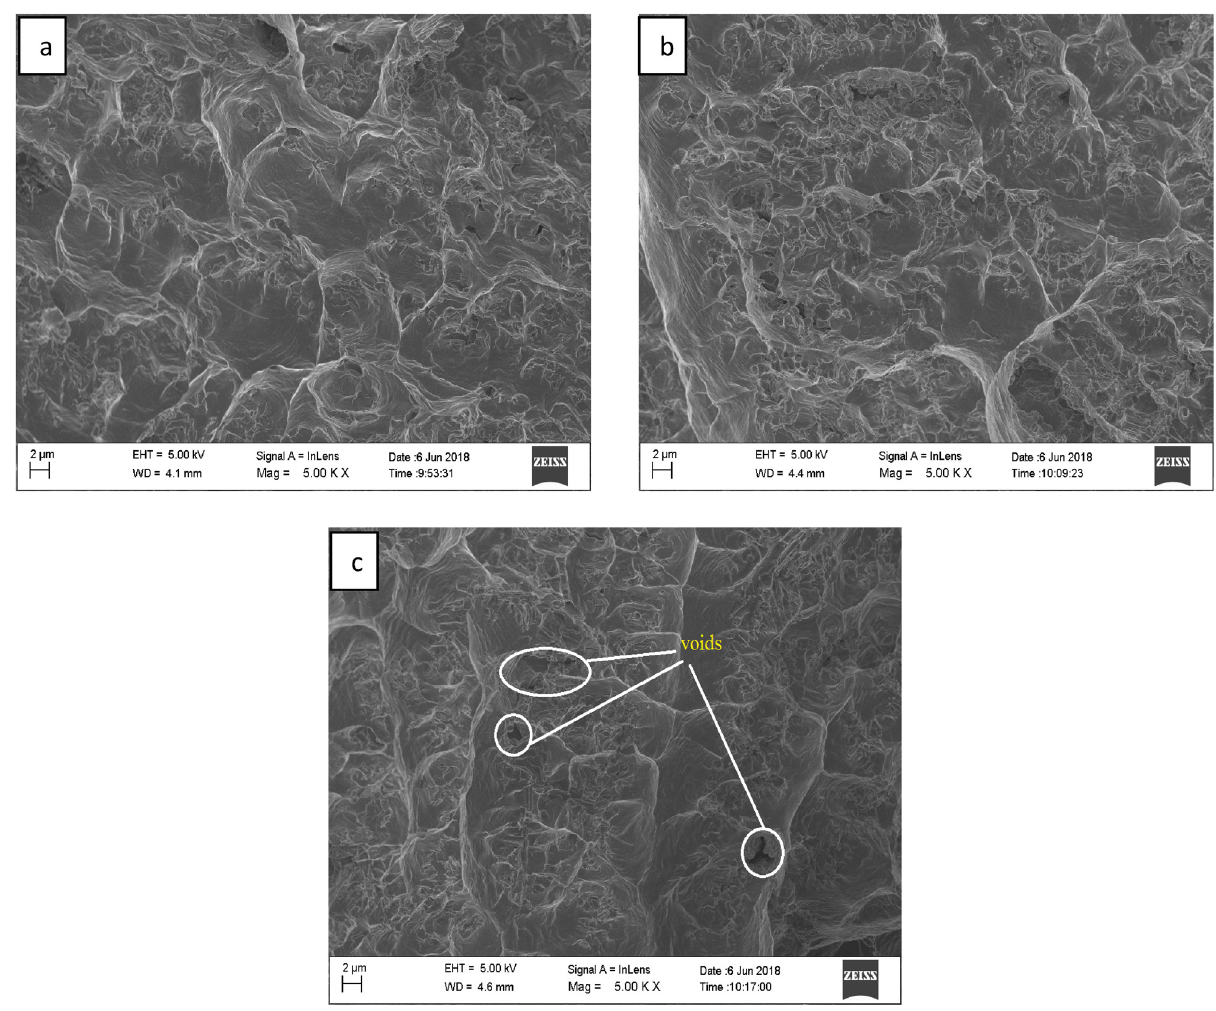
Figure 10: Scanning electron micrograph of fractured surface after tensile test at room temperature: ( a ) I = 80 A, 250 mm · min − 1 ; (